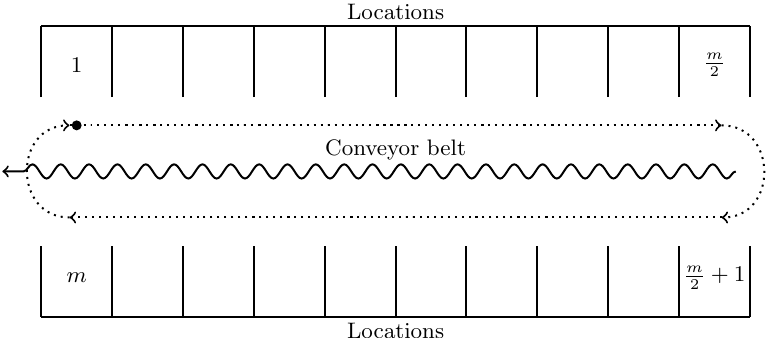
Figure 1: A schematic representation of the layout of a picking line containing m locations. The order picking system considered here functions in waves. A wave is a set of stock keeping units (SKUs) in conjunction with the set of orders (requests from retail